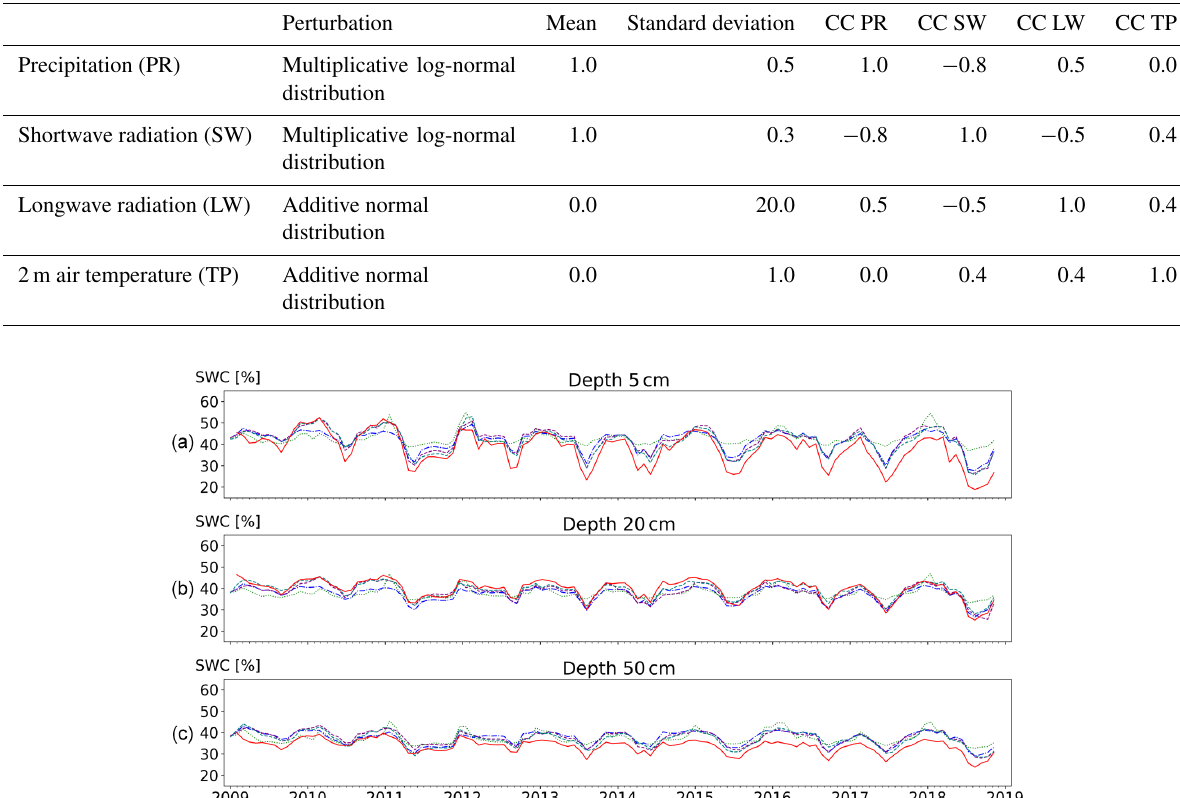
Table 1. Statistical properties and cross-correlation coefficients (CC) used to perturb the atmospheric forcing data.